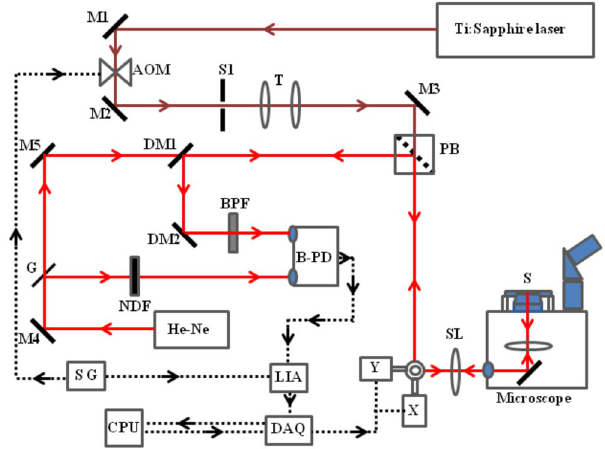
Figure 6. Schematic of laser scanning two-photon photothermal microscope. M: Mirror, AOM: Acousto Optic Modulator, S1: Aperture, T: Telescope, PB: Polarizing Beam splitter, X&Y: Scan Mirrors, SL: Scan Lens, S: Sample, G: Glass slide, NDF: Neutral Density Filter, B-PD: Balanced Photo Receiver, BPF: Band Pass Filter, DM: Dichroic Mirror, DAQ: Data Acquisition card, CPU: Computer, LIA: Lock-In Amplifier, SG: Signal Generator. Continuous line shows the optical path and dotted line represents the electrical signal